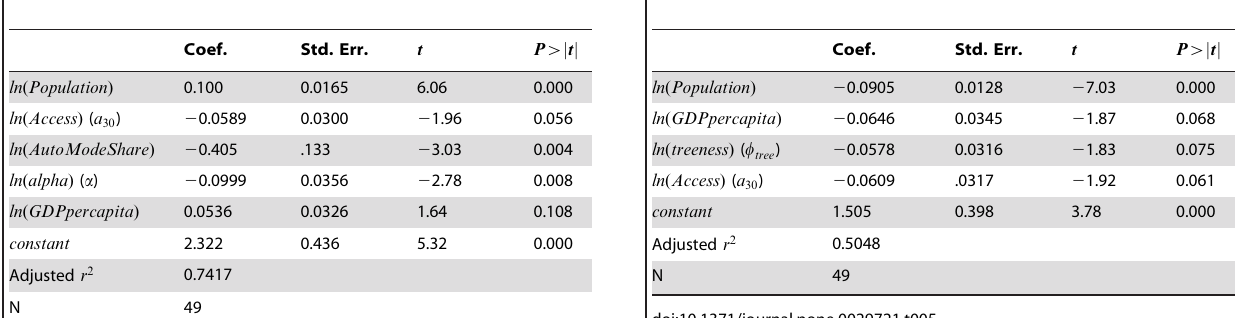
Table 4. Dependent Variable ln ( JourneytoWorkTime ) .